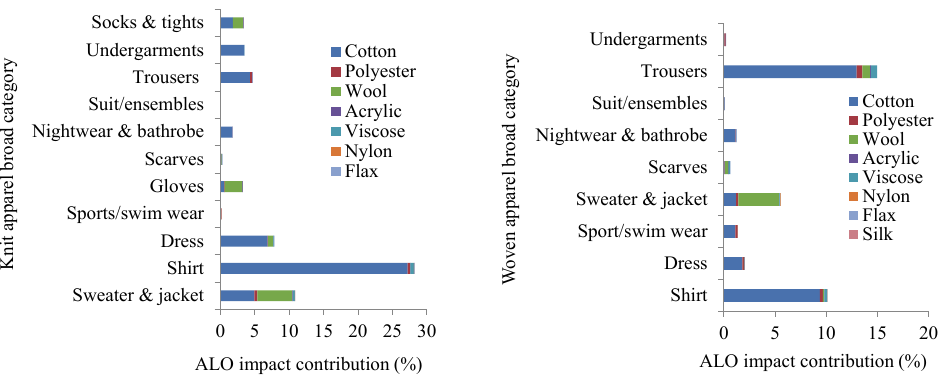
Fig. 16. ALO impact contribution of apparel broad categories based on total market